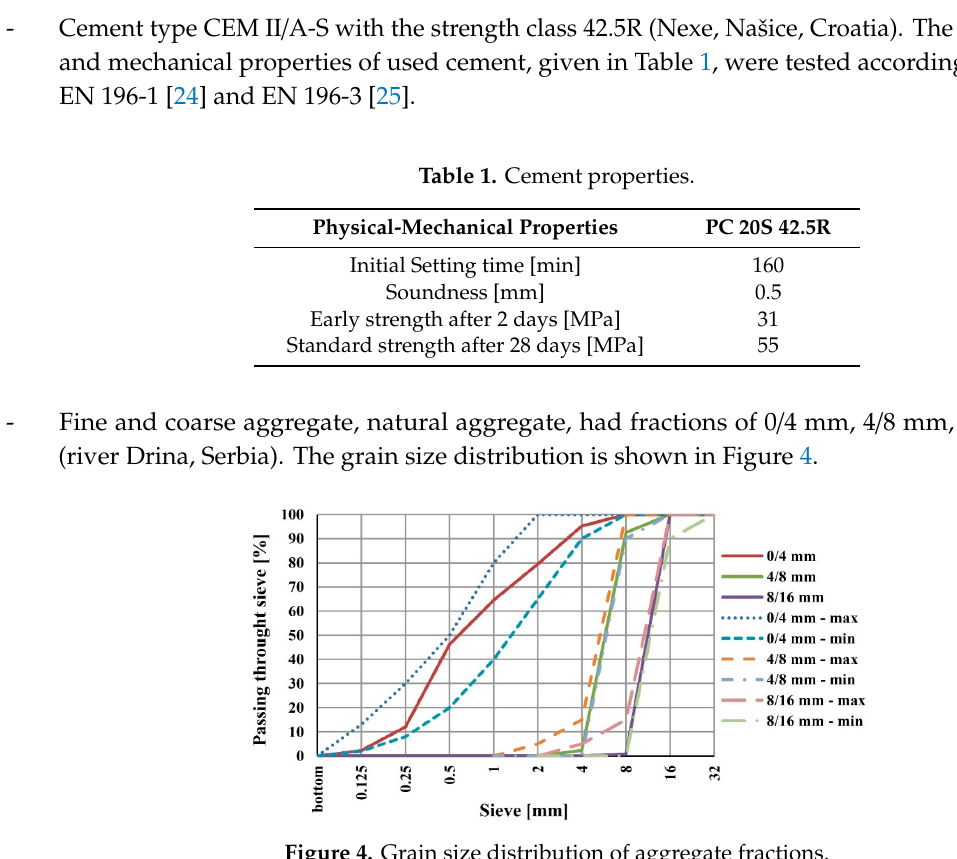
Figure 4. Grain size distribution of aggregate fractions.